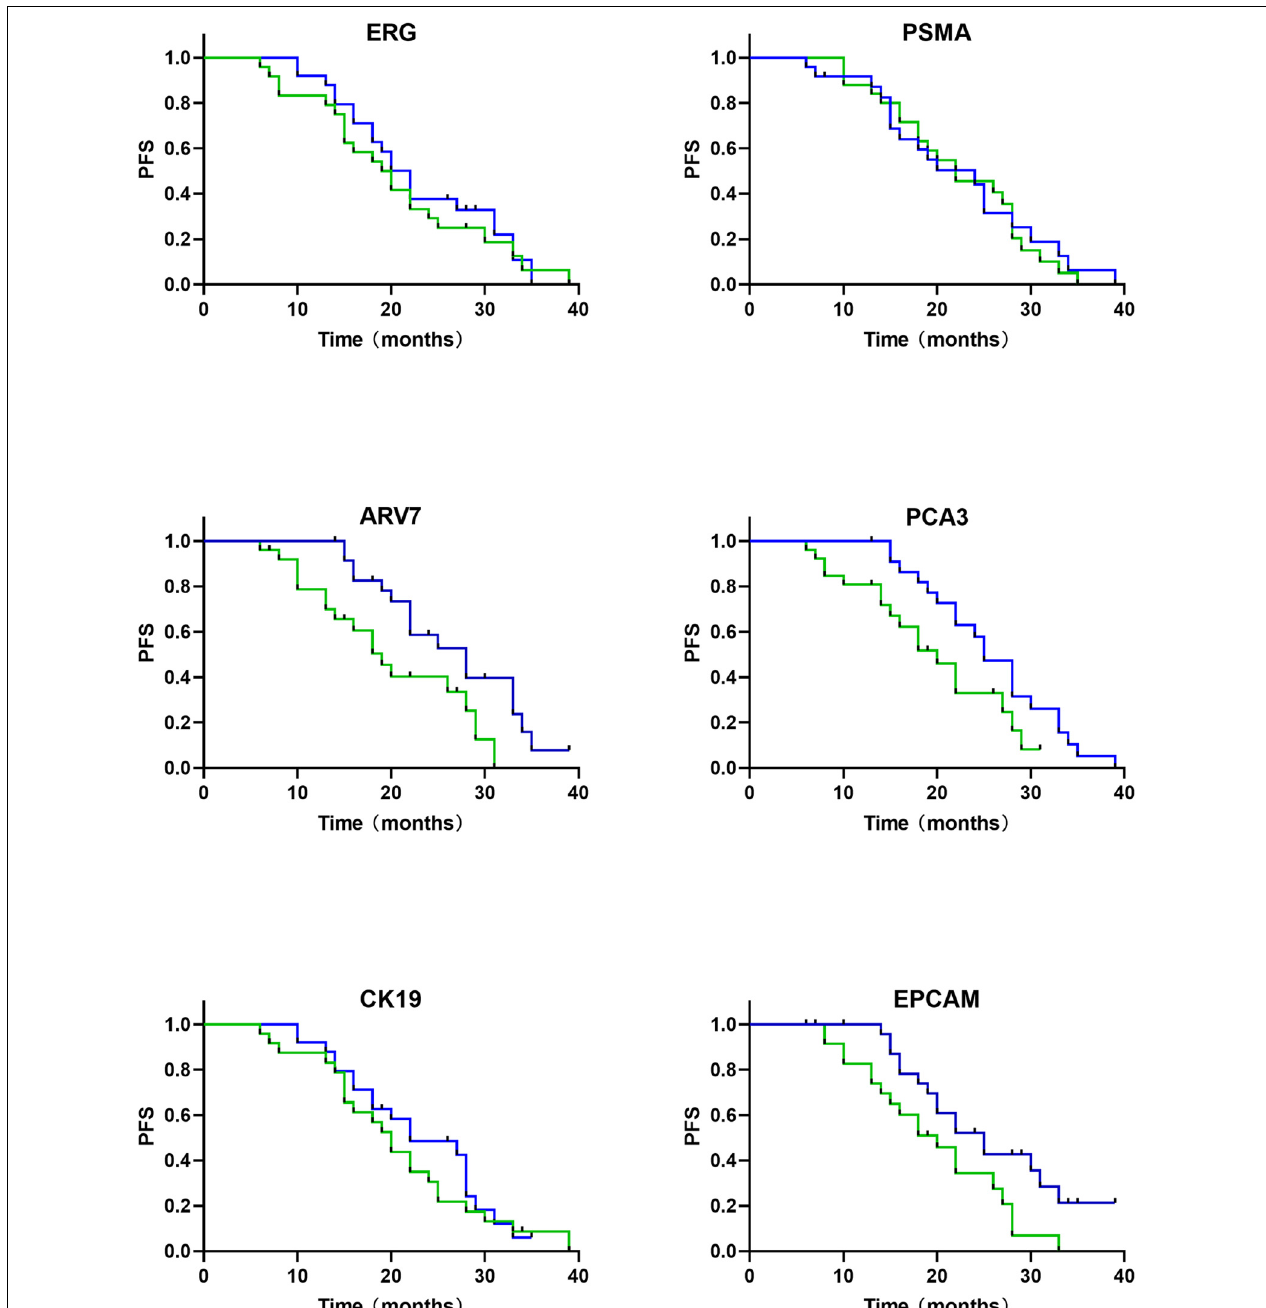
FIGURE 6 | mRNAs based survival analysis in follow-up cohort of PCa patients ( n = 63) (time in months). Kaplan-Meier curves show that relative expression levels of mRNA are associated with androgen-deprivation therapy (ADT) failure time (green, high expression of mRNA; blue, low expression of mRNA).